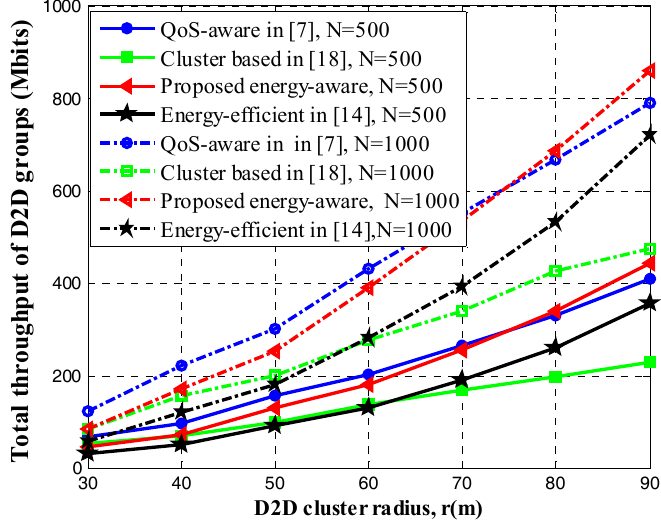
Figure 2. Cluster Energy Efficiency versus D2D cluster radius. QoS: quality of service .